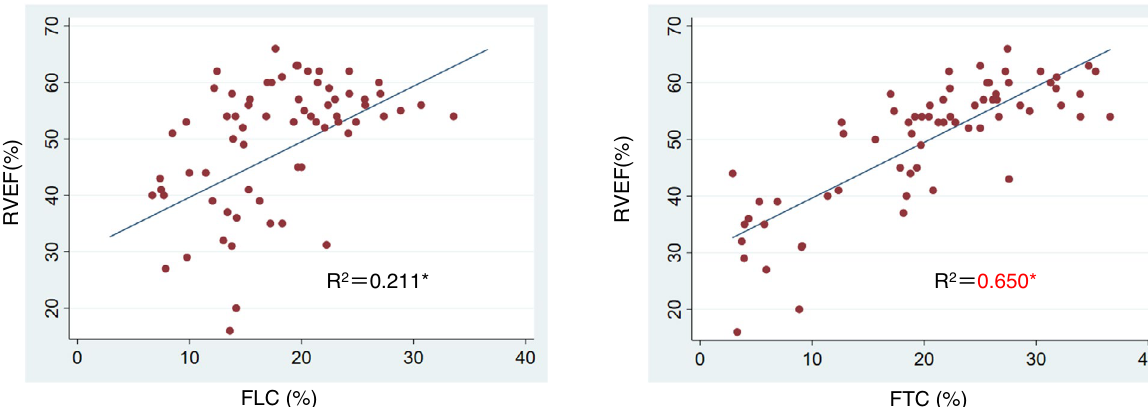
Figure 4. Scatter plots and linear regression lines for the preliminary parameters, FLC and FTC, versus RVEF. Univariate linear regression analysis revealed a mild correlation between FLC and RVEF (R 2 : 0.211; p < 0.001), while the correlation between FTC and RVEF was strong (R 2 : 0.650; p < 0.001). *Univariate linear regression